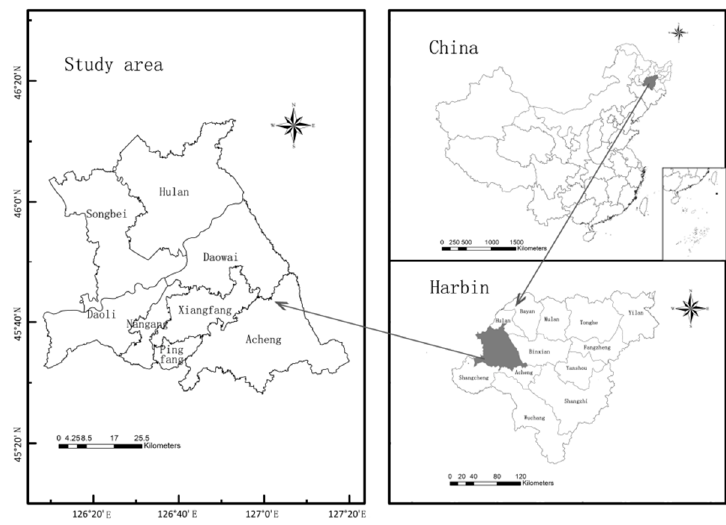
Figure 1. Schematic of study area.